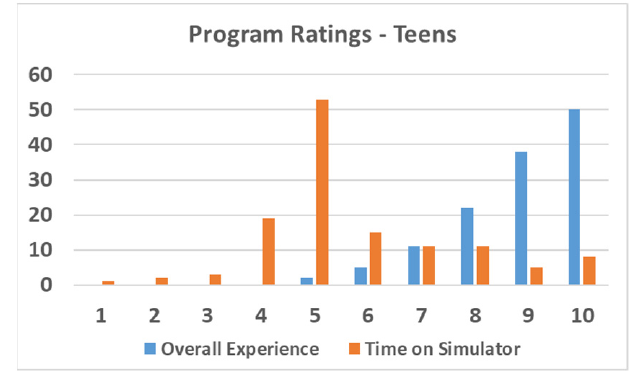
Figure 17. Teen Assessment Experience/Time on Driving Simulator.